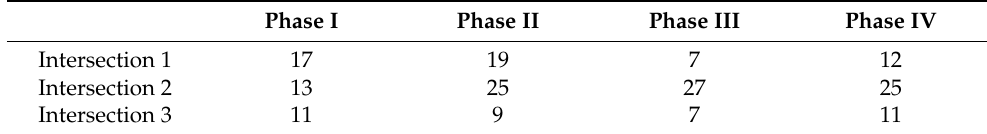
Table 7. Estimated frequency of horn use if the duration of each green light phase is 10